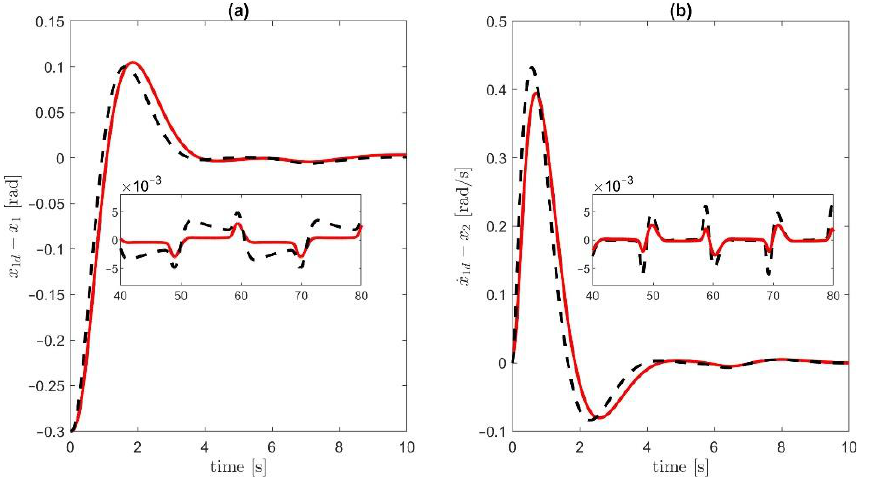
. x 1 d − x 2 . Dashed black line— k 1 = k 2 = k 3 = = 𝑘 = 𝑘 = 𝑘 = 15 . 1 2 3 4 (cid:104) (cid:105) rad results in the reversal motion s